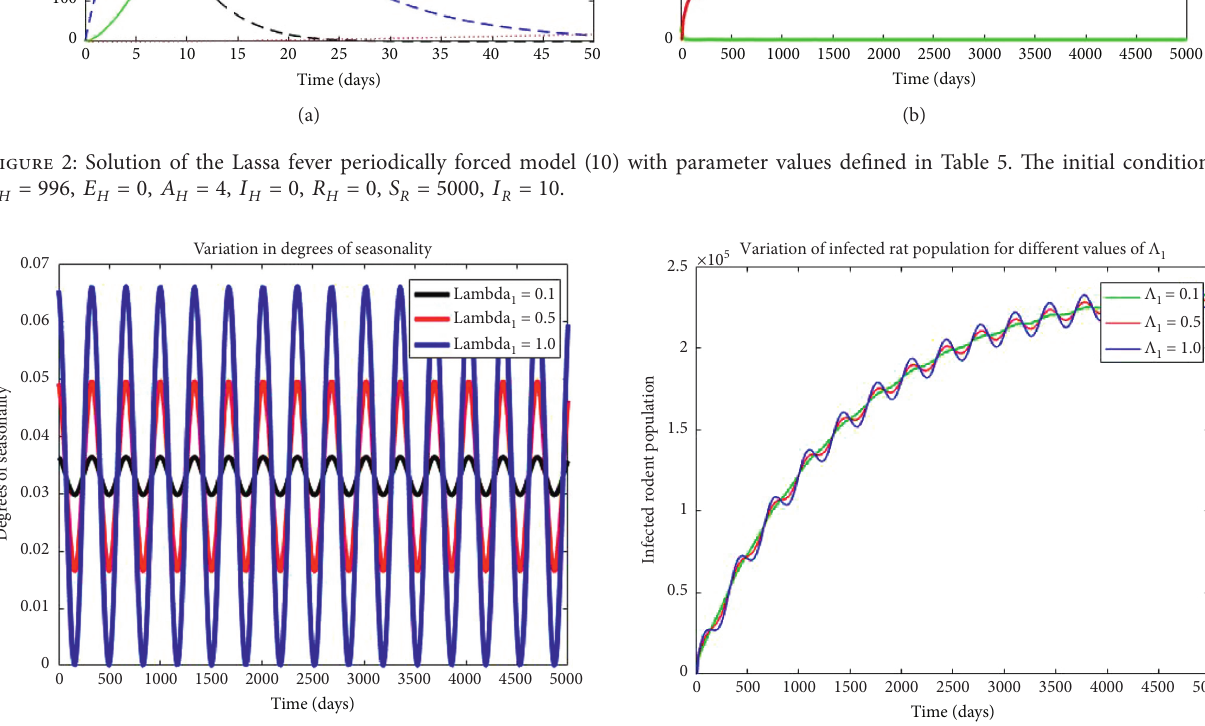
� 0 . 1, Λ � 0 . 5, Λ � 1 . 0. such that Λ 1 1 1 1